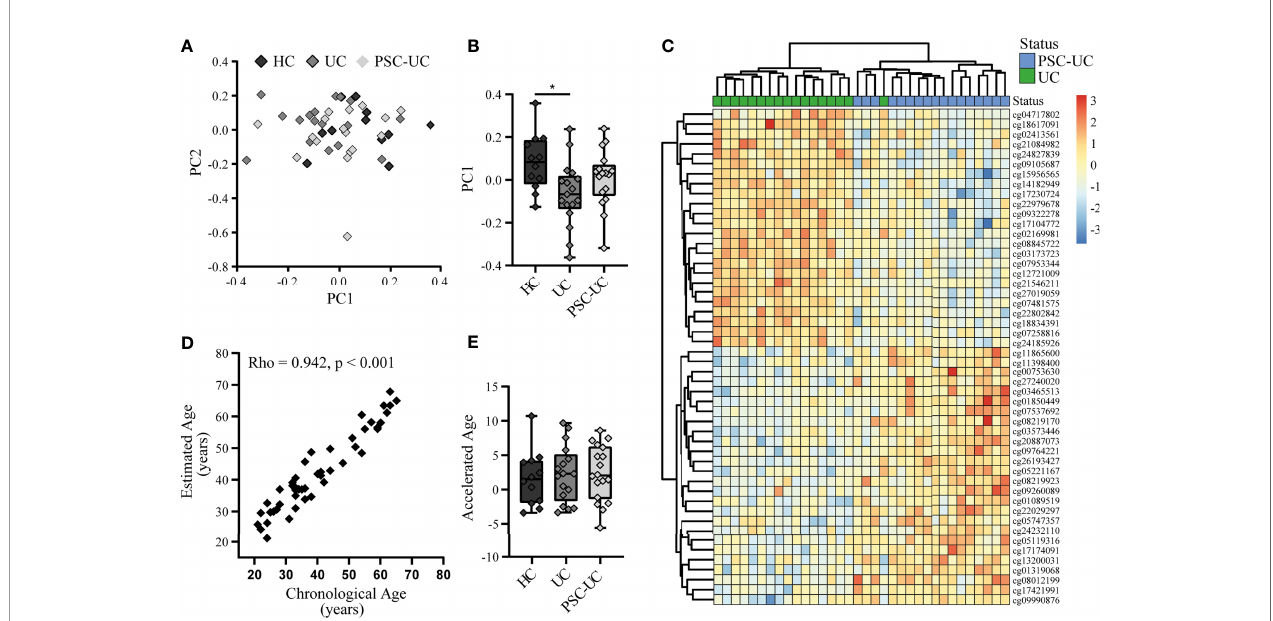
FIGURE 1 | The genome-wide methylome of patients with PSC-UC is comparable to that from patients with UC and healthy controls. (A) Principal component (PC) analysis of the methylome of patients with PSC-UC (light grey), UC (grey) and HC (dark grey). (B) Association of PC1 with all groups. (C) Heatmap of top 50 differentially methylated positions between PSC-UC (blue) and UC (green). (D) Correlation between chronological age (years) and estimated DNA methylation age (years) in patients with PSC-UC, UC and HC. (E) Comparison of accelerated age (difference between chorological age and estimated age) between patients with PSC-UC, UC and HC. A p-value <0.05 was considered statistically signi fi cant (*p <